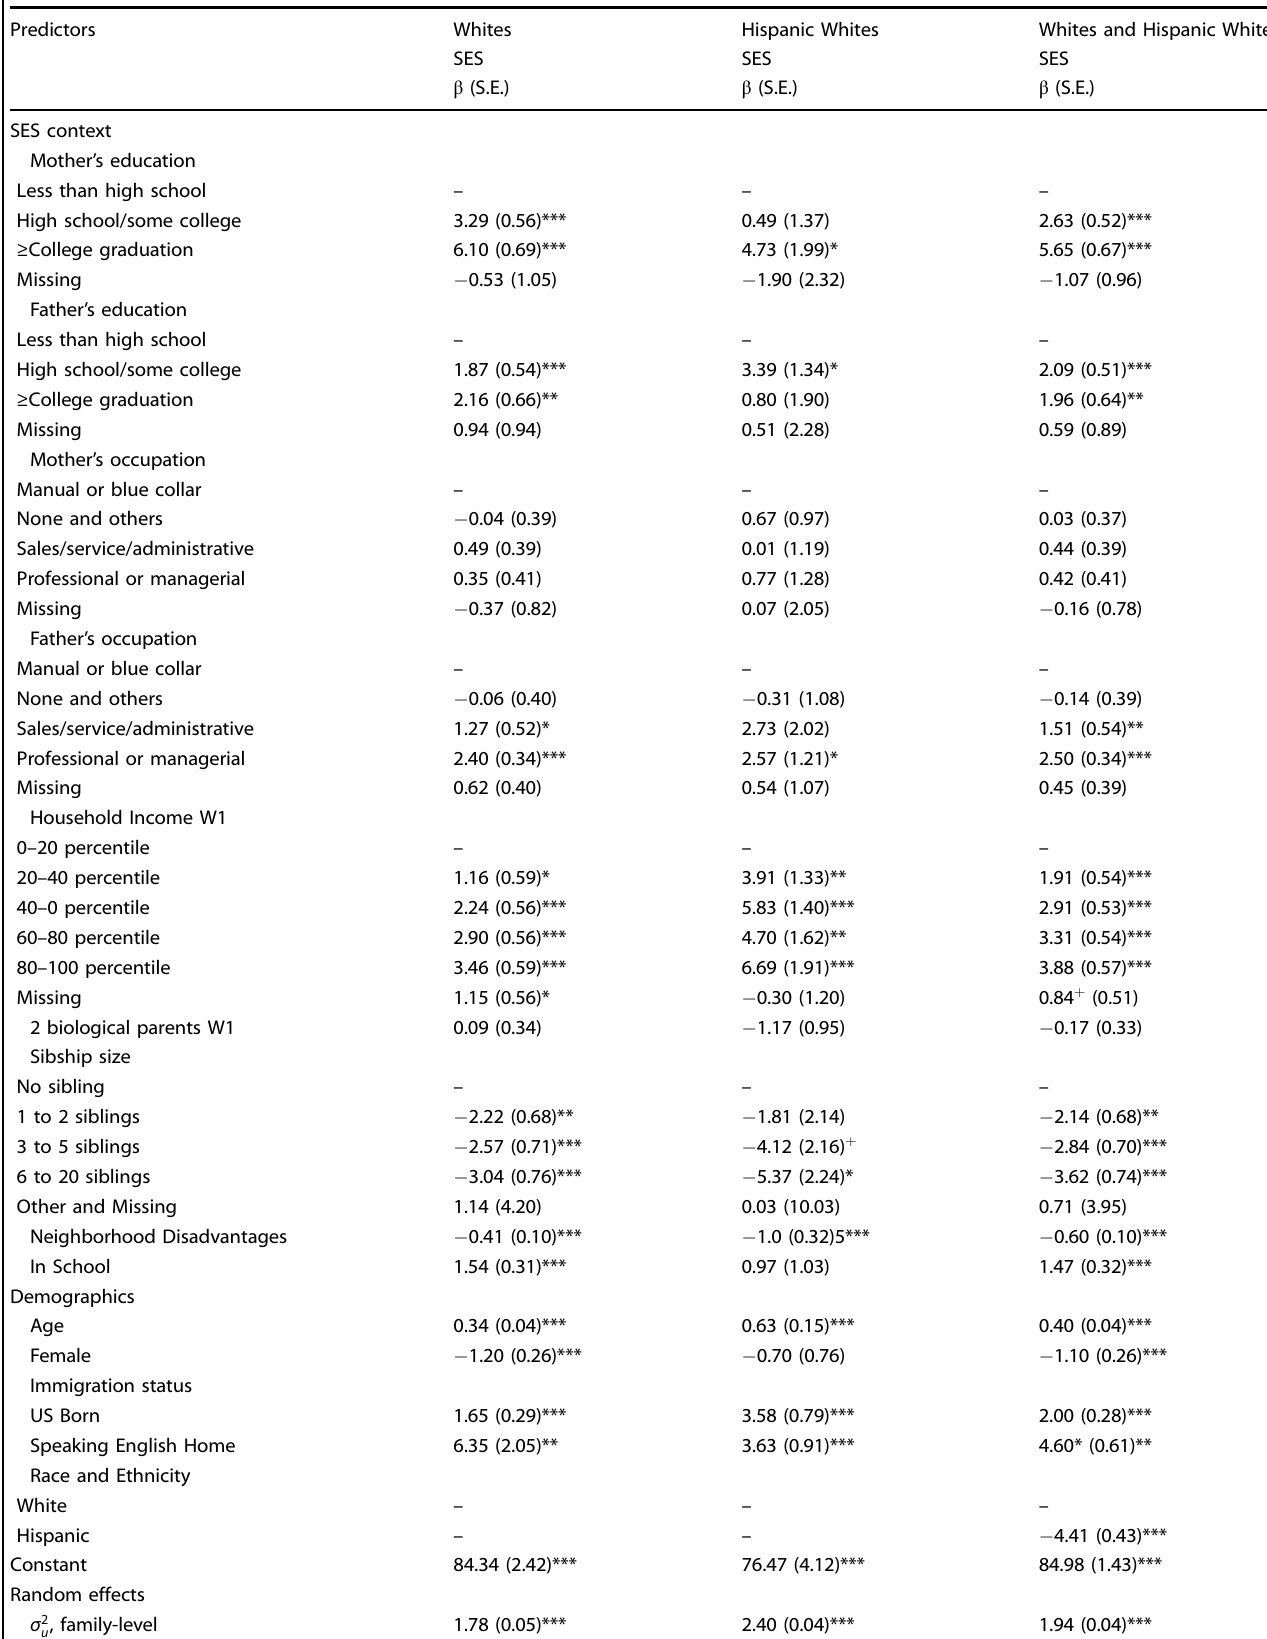
Table 2. Multilevel models of Wave-1 and 3 verbal ability showing coef fi cients (standard errors) of SES